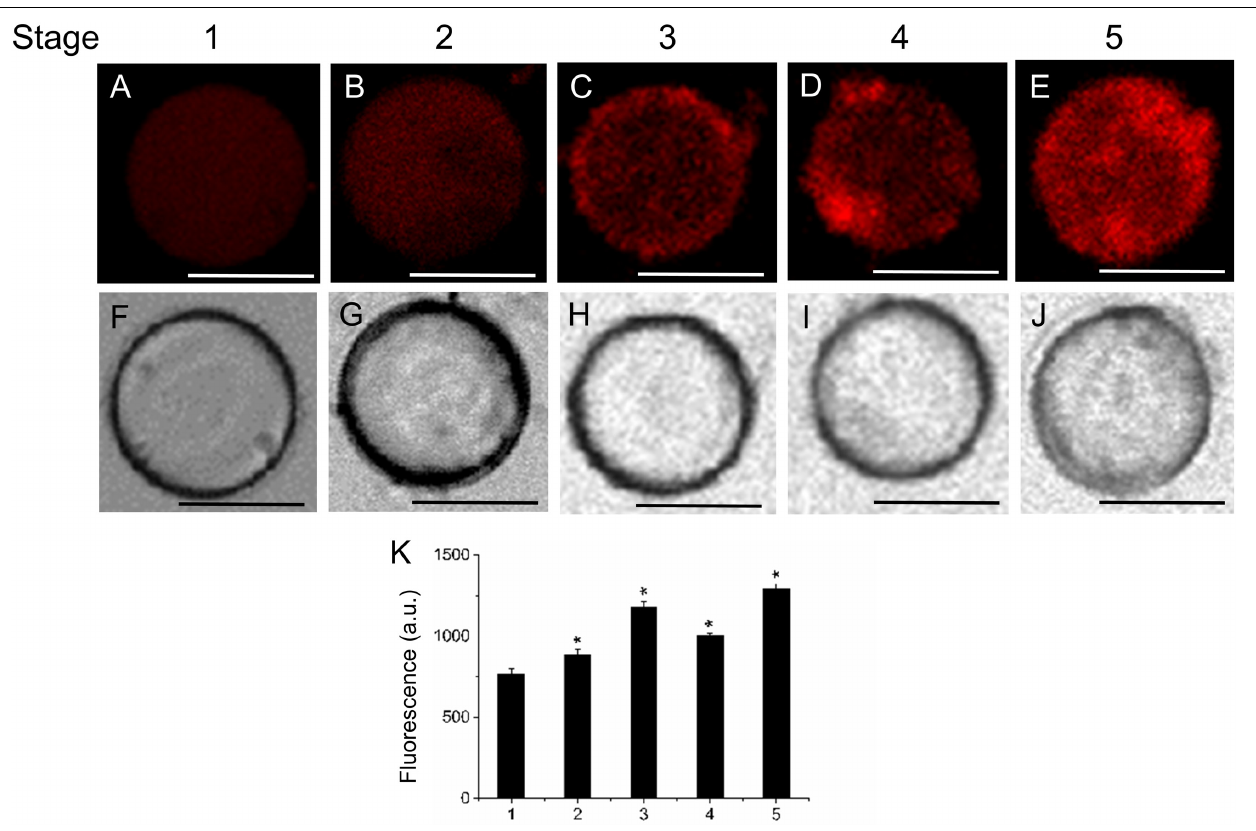
FIGURE 5 | Changes in vesicle trafficking in live protoplasts from olive fruit during development. (A–E) FM4-64 stained protoplasts from the olive fruit at different stages of development compared to the white light image (F–J) . Scale bars are 10 µ m. (K) Relative FM4-64 internalization fluorescence intensity in live protoplasts from olive fruit at different stages of development. Data from about 20 protoplasts were acquired per sample, and data were compiled using FV10 4.2 software (Olympus). Values are means ± SD ( n = 20 protoplasts). Statistically significant differences from the preceding point based on unpaired Student’s t -test at P < 0.05 are denoted by